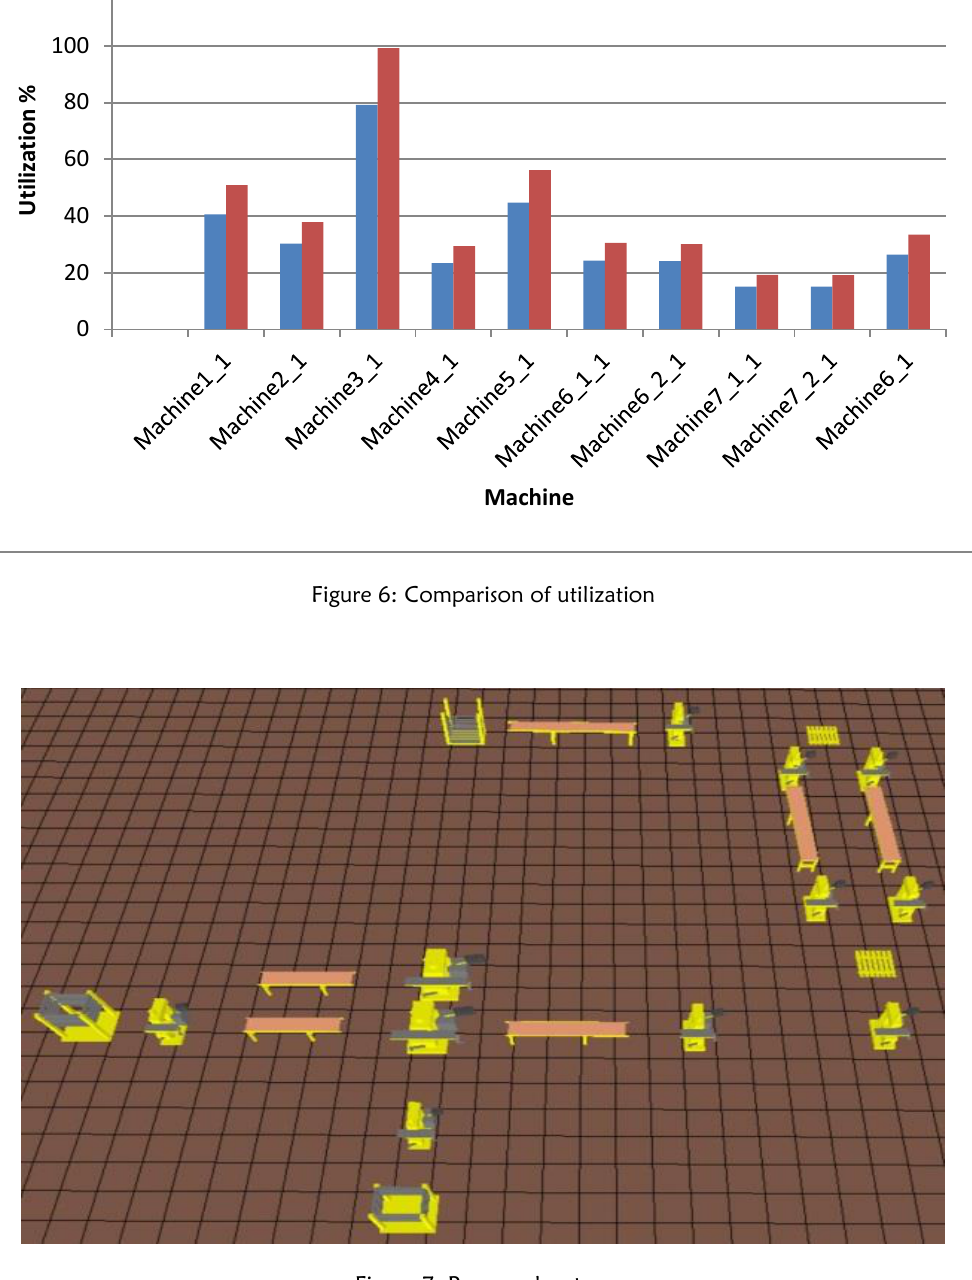
Figure 7: Proposed